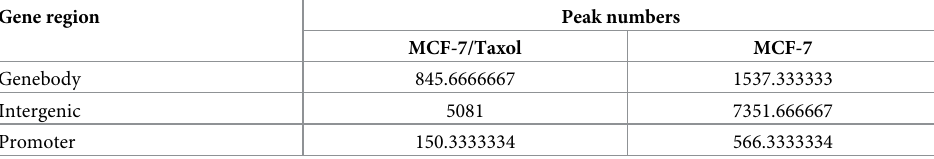
Table 3. The number of methylation peaks in the